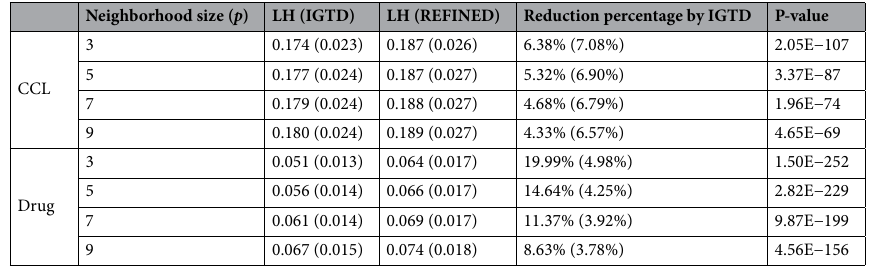
Table 1. IGTD reduces the local heterogeneity (LH) of image representations compared with REFINED. In the LH and reduction percentage columns, the number before the parenthesis is the average value obtained across CCLs or drugs, and the number in the parenthesis is the standard deviation. P-value is obtained via two- tail pairwise t-test comparing the LH between IGTD images and REFINED images across CCLs or